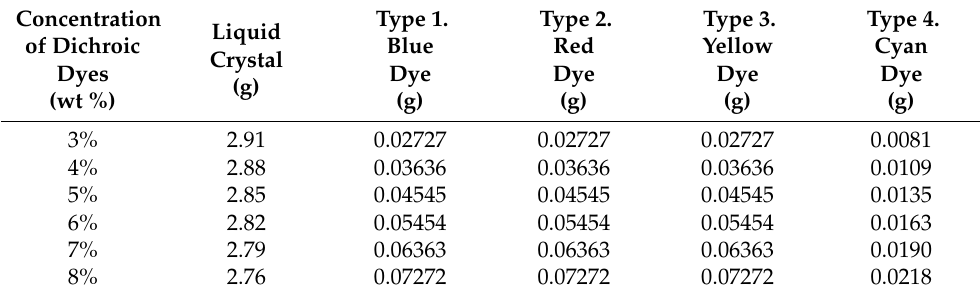
Table 7. Concentrations of blue, red, yellow and cyan for black dye development. Concentration